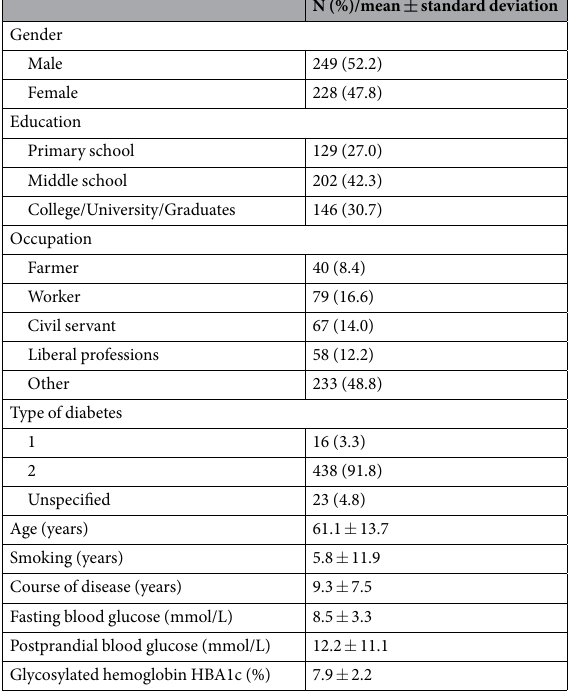
Table 2. Characteristics of